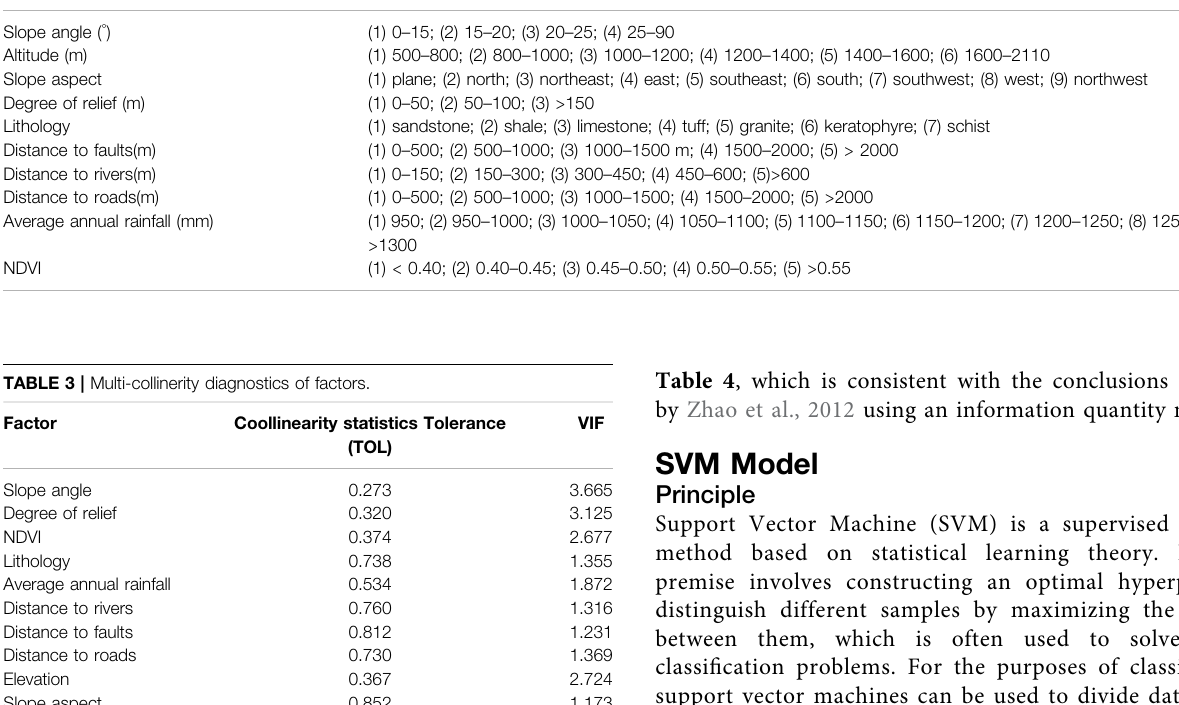
TABLE 2 | Conditioning factor categories.